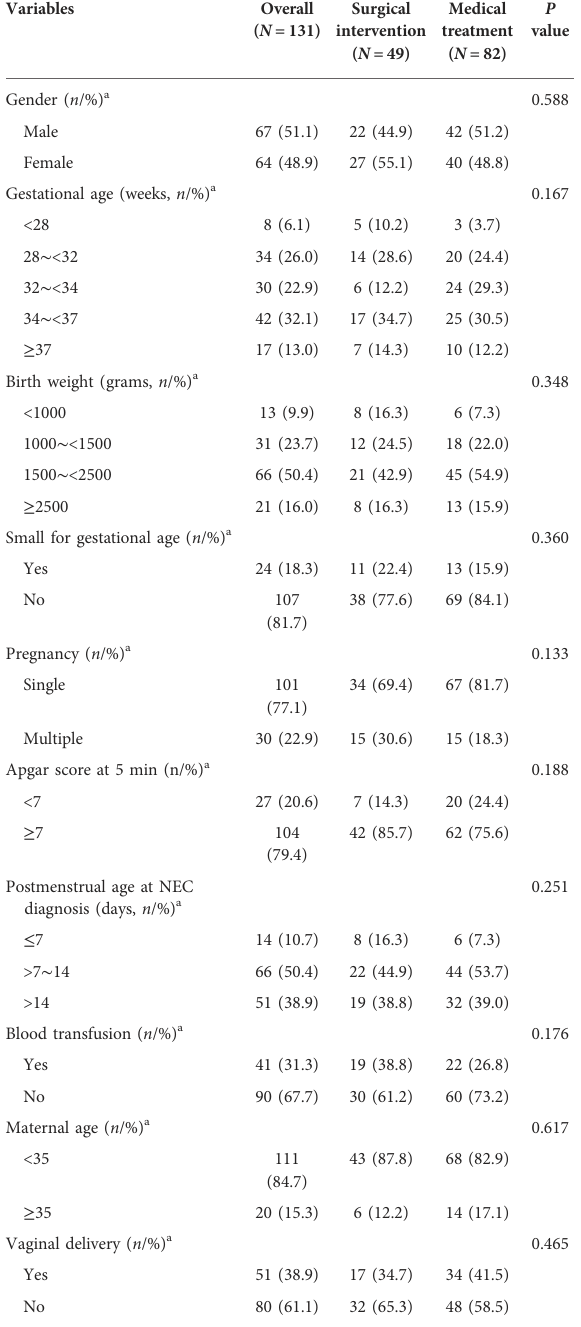
TABLE 2 Univariate analysis of general demographics on different treatment strategies for